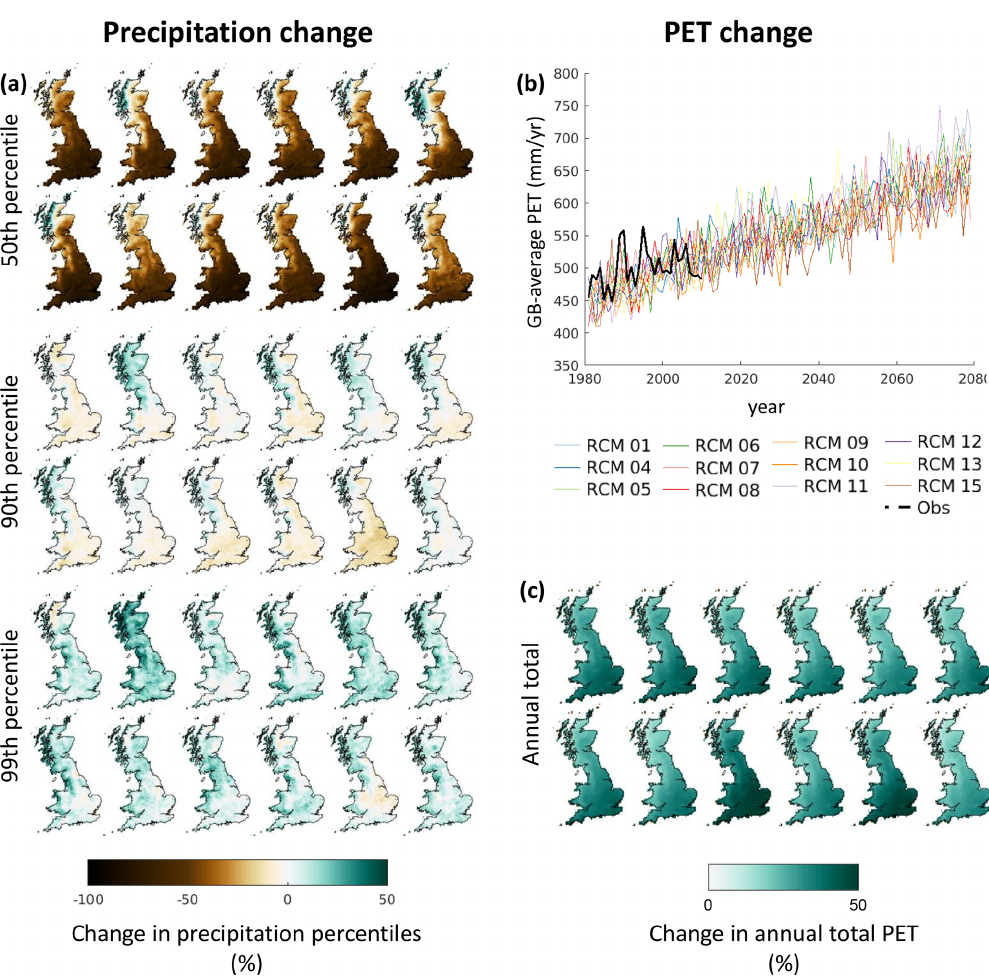
Figure 2. Precipitation (a) and PET (b, c) change. GB maps are presented for each ensemble member in order. Top row: RCM01, RCM04, RCM05, RCM06, RCM07, RCM08; bottom row: RCM09, RCM10, RCM11, RCM12, RCM13,